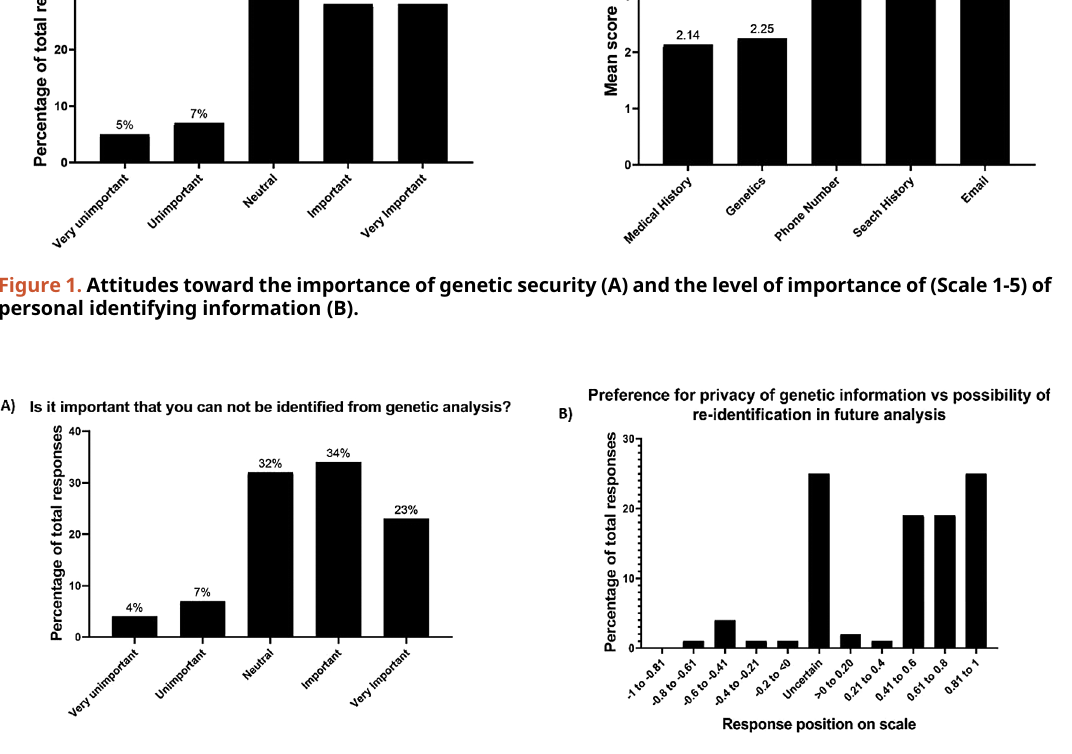
Figure 2. Attitudes towards the importance of genetic privacy (A) and preference for genetic privacy versus re-identifiability, where (cid:1) 1 is total genetic privacy and 1 is total re-identifiability